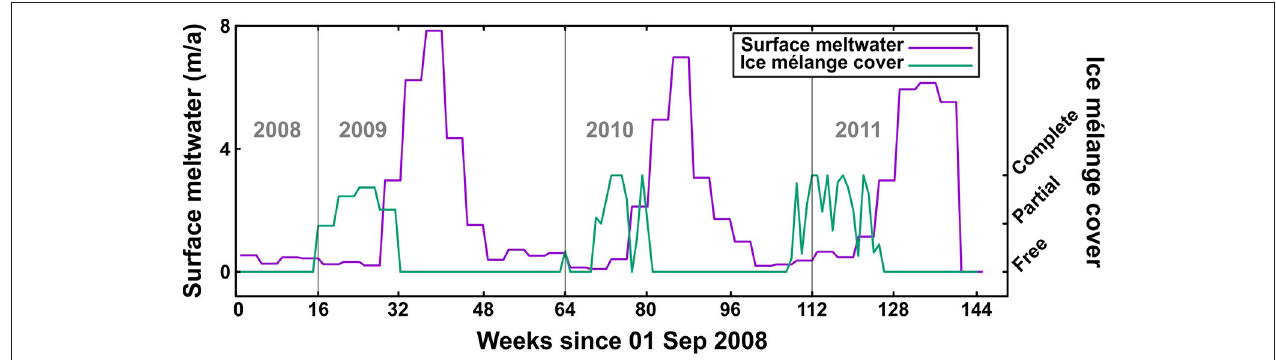
FIGURE 4 | Modeled surface meltwater near the calving front (purple line) and observed ice mélange coverage (weekly average of daily observations) in the glacier forebay (green). Week means here 1/48 of a year.